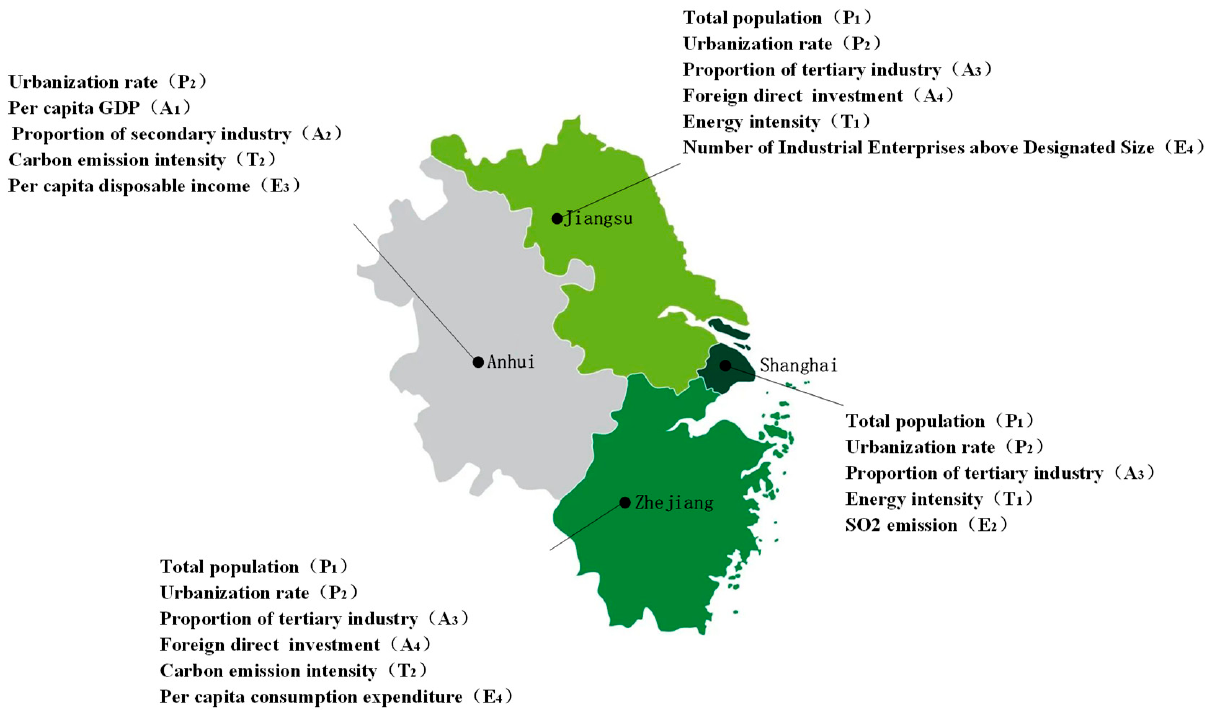
Figure 5. Critical influencing factors selection result chart. Table 3. Improved STIRPAT Model of four